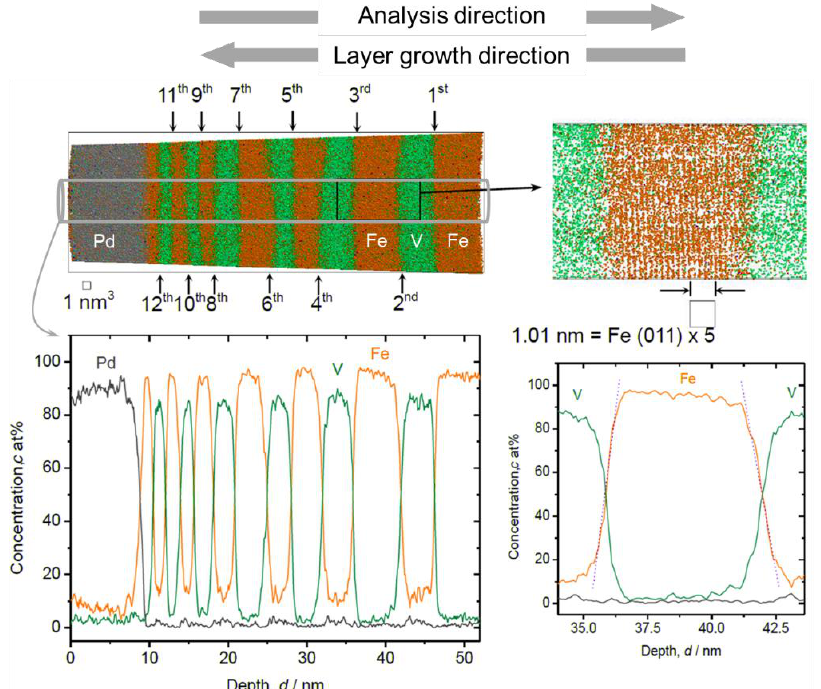
Figure 1. 3D reconstruction volume (18 nm × 18 nm × 53 nm) and 1D concentration profile of Fe/V multi-layered film on W deposited at 603 K (grey: Pd, green: V, orange: Fe), with a magnified V/Fe/V interface (right hand side). The number of Fe/V interface (12 in total) is indicated as the order number. Depth concentration profiles were taken from a 5 nm ϕ cylinder volume (colored in grey).